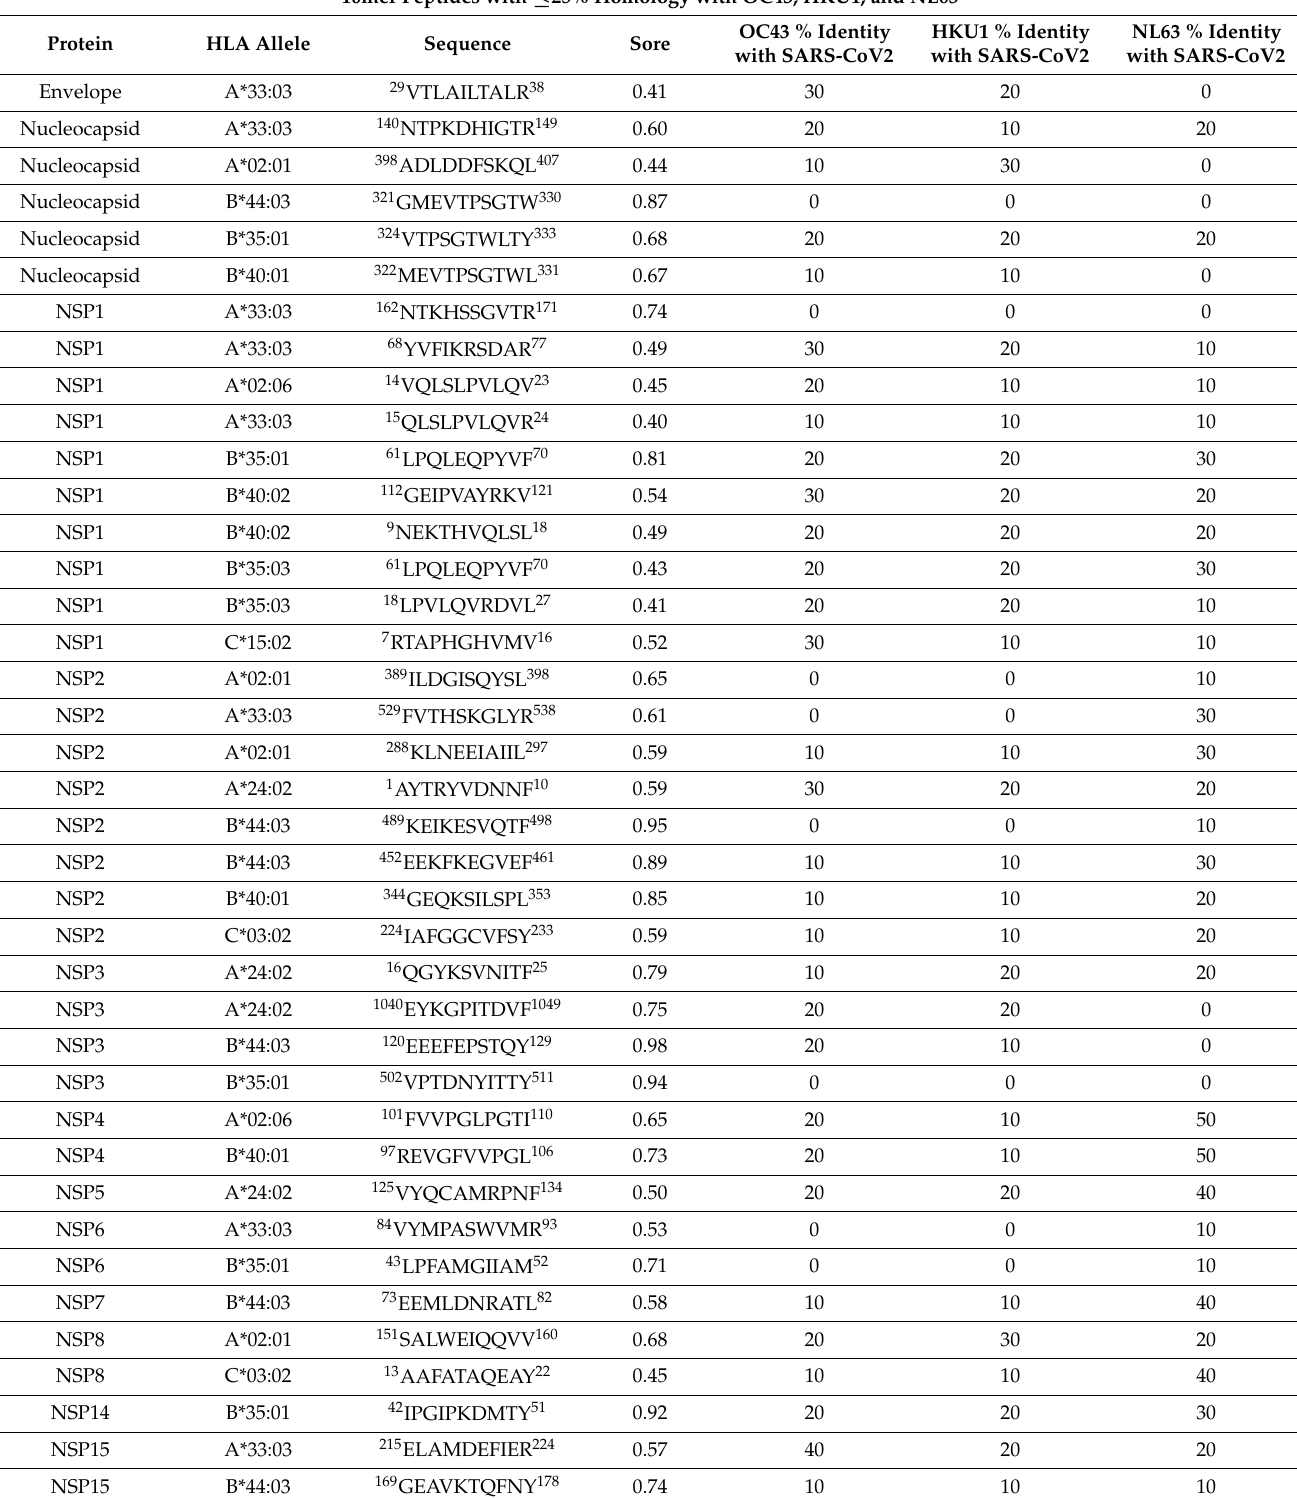
10mer Peptides with ≤ 25% Homology with OC43, HKU1, and